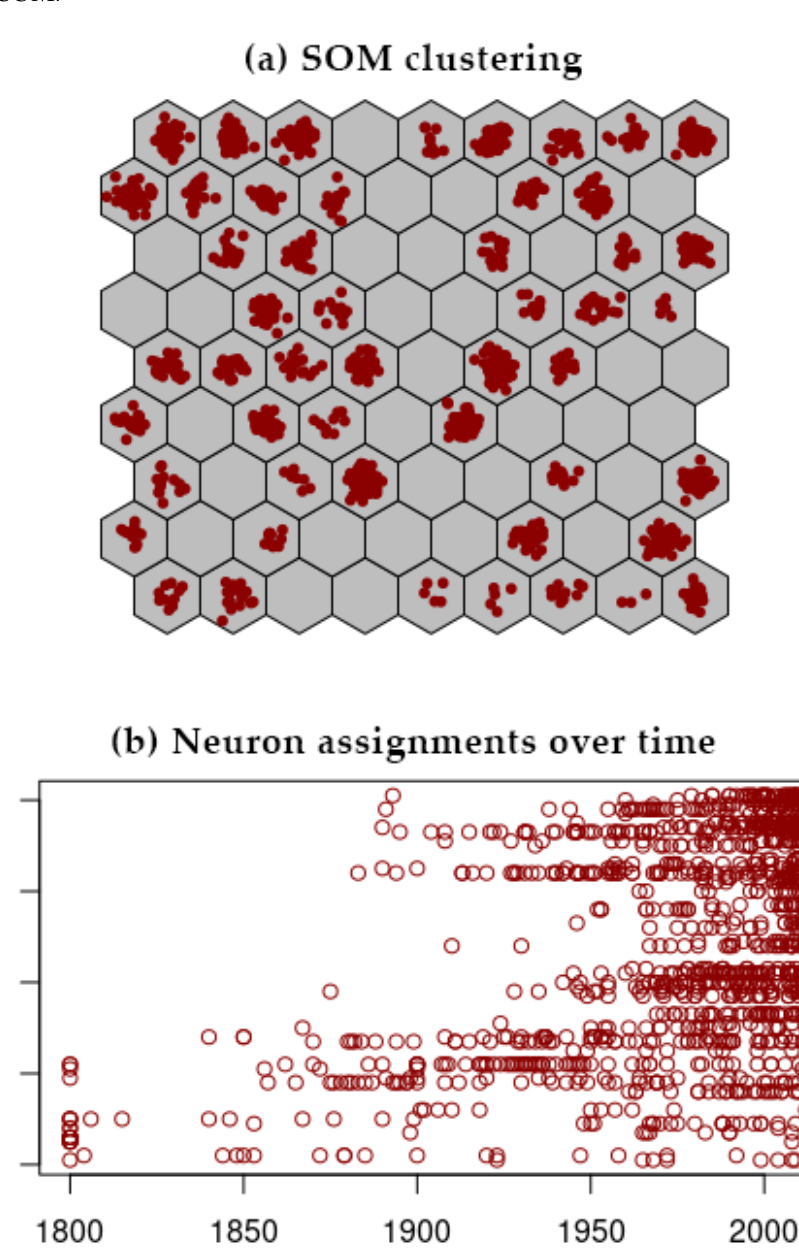
Figure 1. ( a ) SOM clustering for the germplasm of 1219 potato accessions of various origins. Each dot represents a potato accession. Neurons are numbered from bottom left of the grid (1) to top right (81); ( b ) Neuron assignments over time in years. Each circle represents a potato accession.